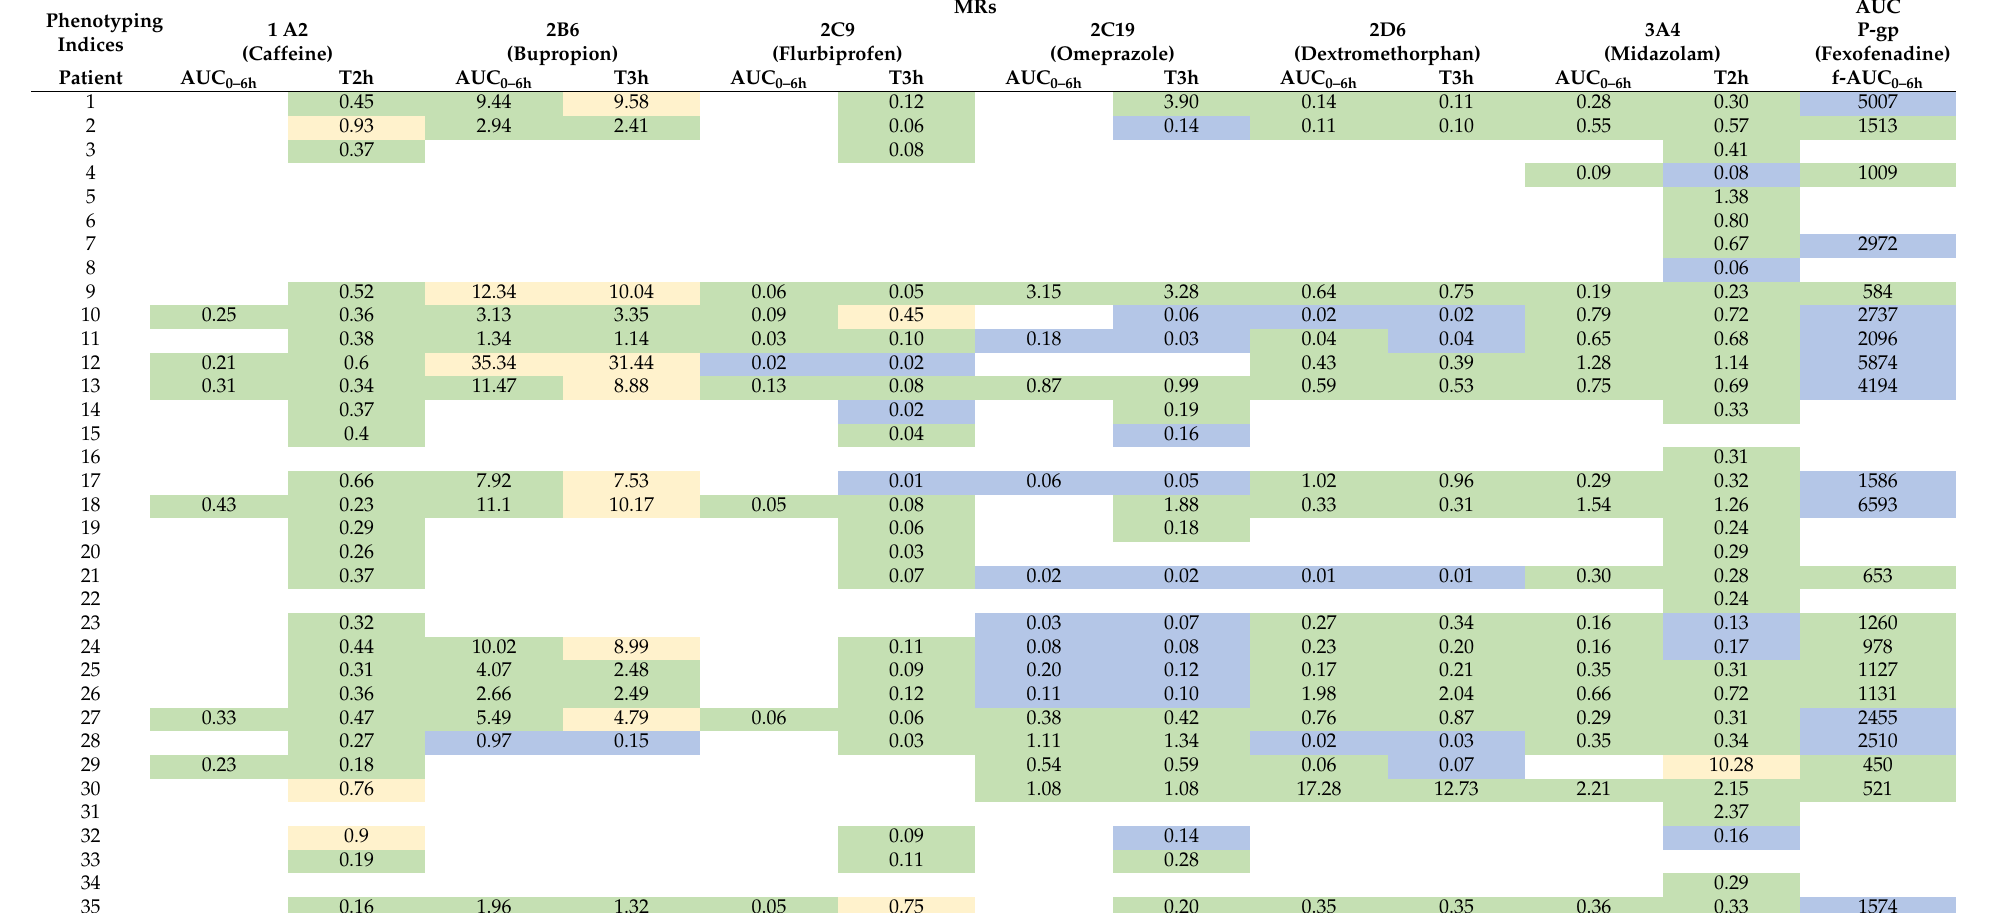
Table A6. Individual phenotyping indices. For CYP, patients’ results are MRs on the chosen single point and AUC 0–6h . For P-gp, patients’ results are f-AUC 0–6h . Patients are classified according to confidence interval: in green, normal activity; orange, increased activity; blue, decreased activity; dark blue, genetic ranges of decreased